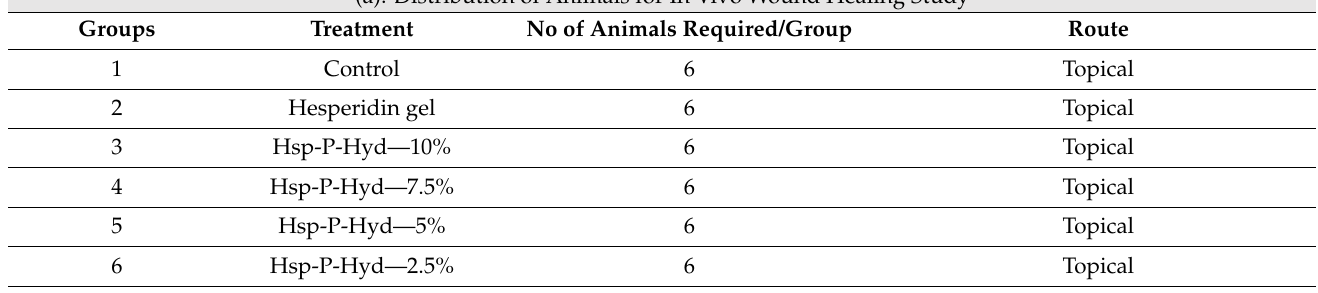
Table 1. ( a ) Distribution of animals for the in vivo wound healing study; ( b ) Percentage wound contraction evaluation post treatment with Hesperidin gel, Hsp-P-Hyd 2.5%, Hsp-P-Hyd 5%, Hsp- P-Hyd 7.5%, Hsp-P-Hyd 10%. Wounds not treated were considered as control; ( c ) Skin irritation evaluation after treatment with Hsp gel and Hsp-P-Hyd